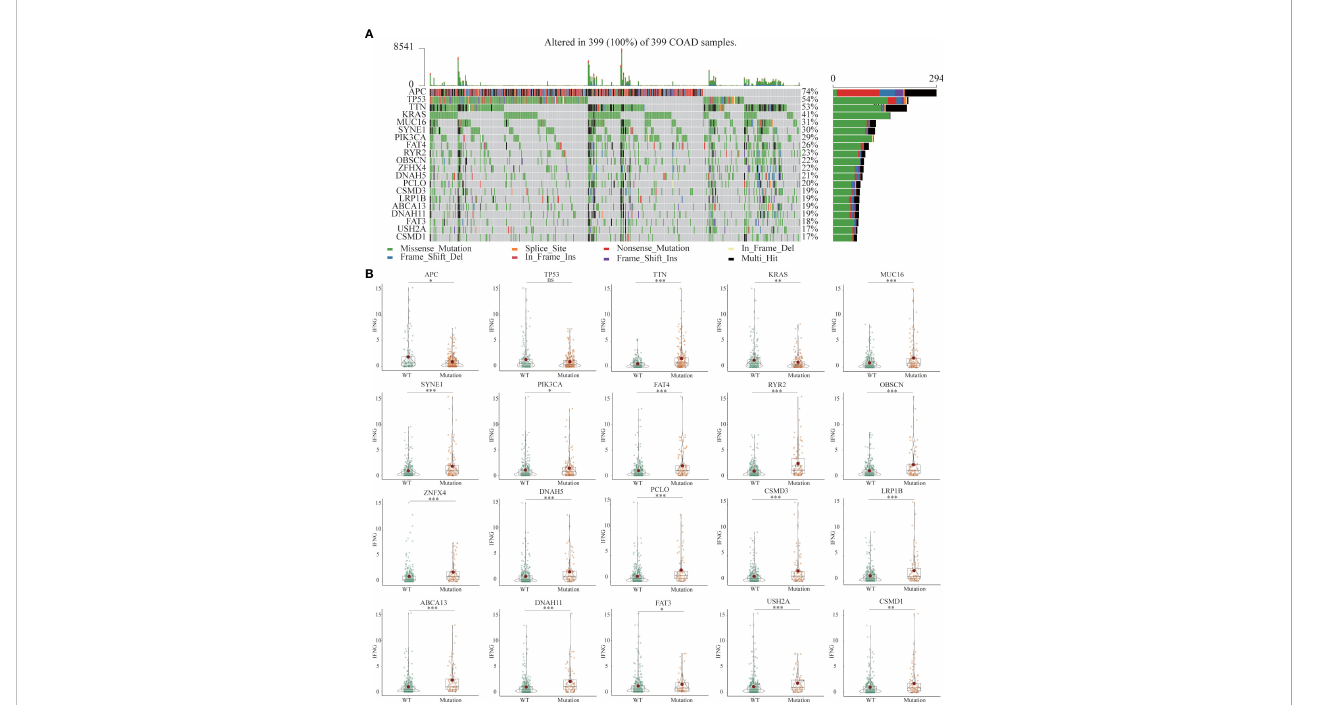
FIGURE 11 (A) The landscapes of somatic mutations of TCGA-COAD patients. (B) Among the top 20 mutant genes, differential expression of IFNG between wild- type (WT) and mutant tissues. (*P-value <0.05; **P-value <0.01; ***P-value